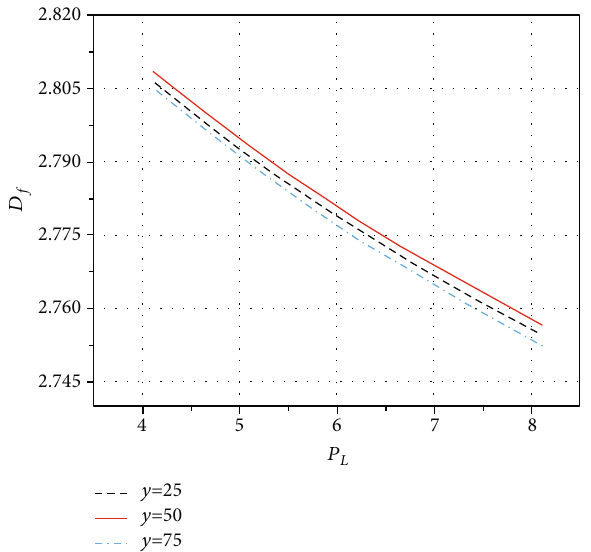
Figure 13: In fl uence of Langmuir pressure constant P fractal dimension D